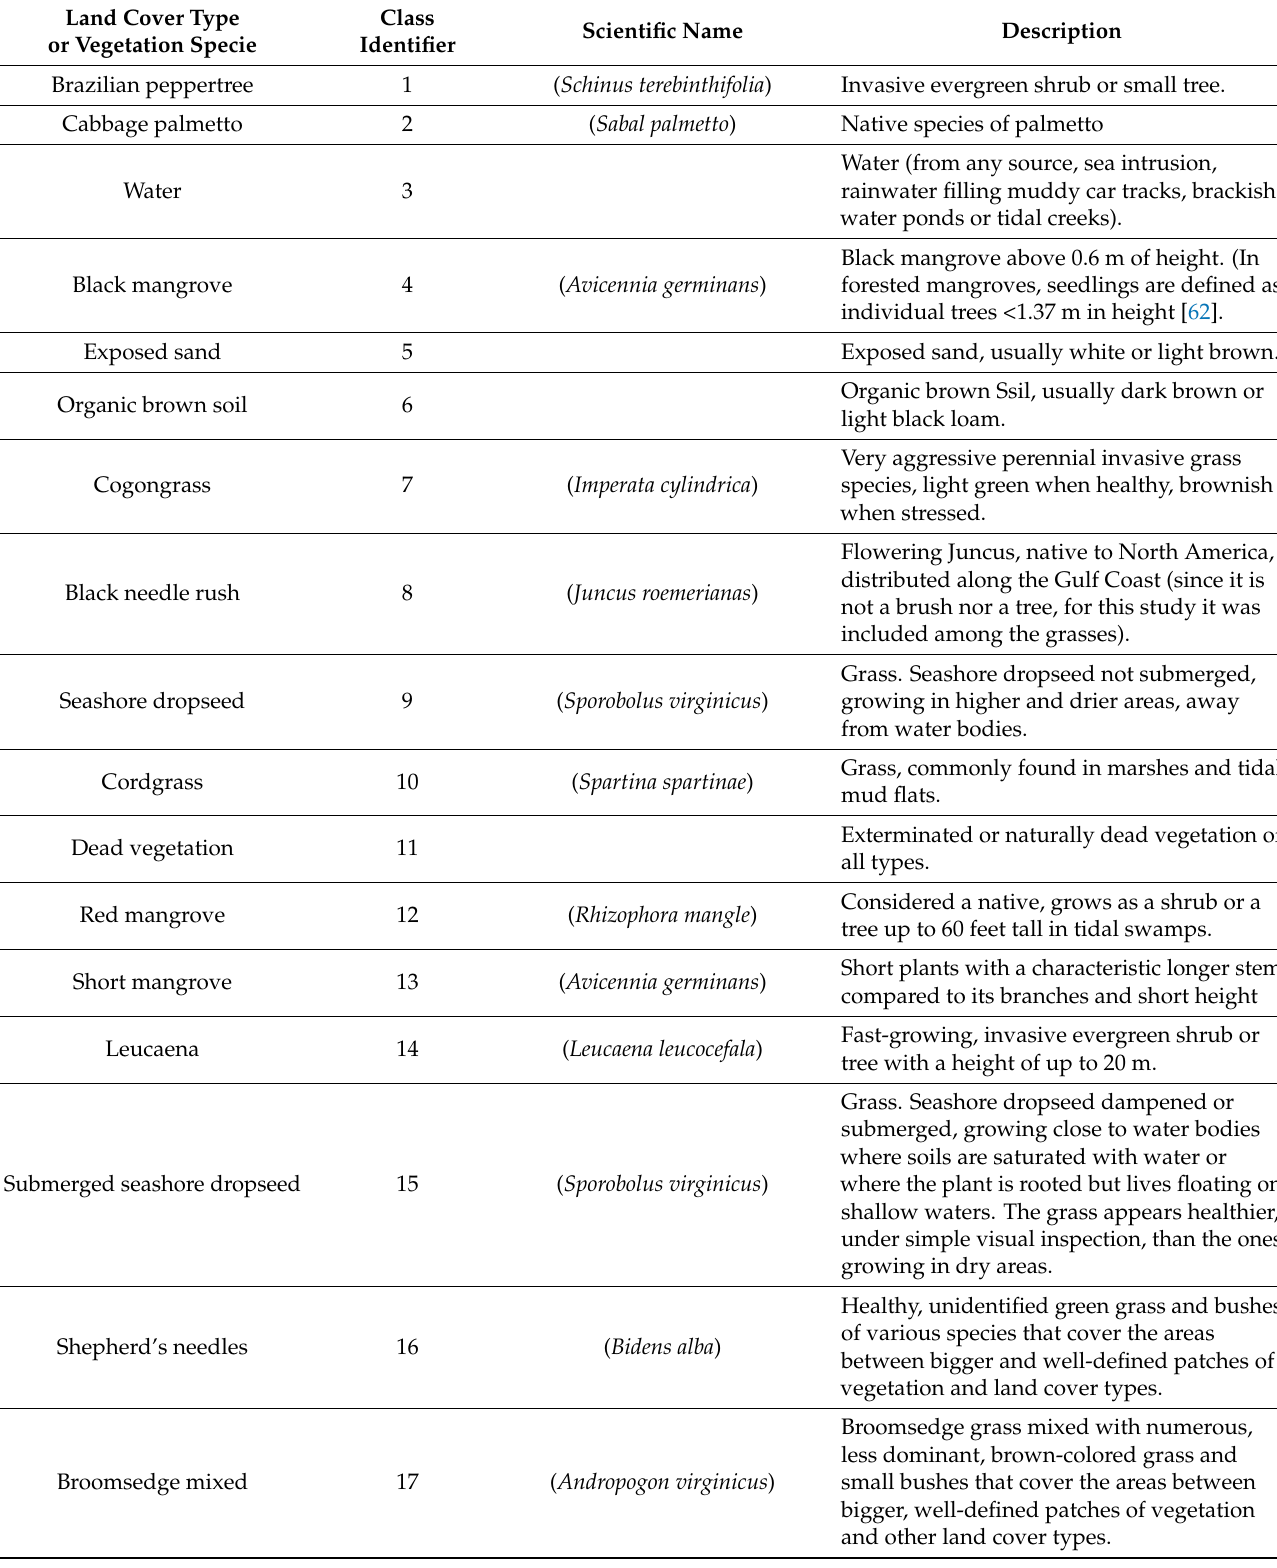
Table 1. Classes defined for the